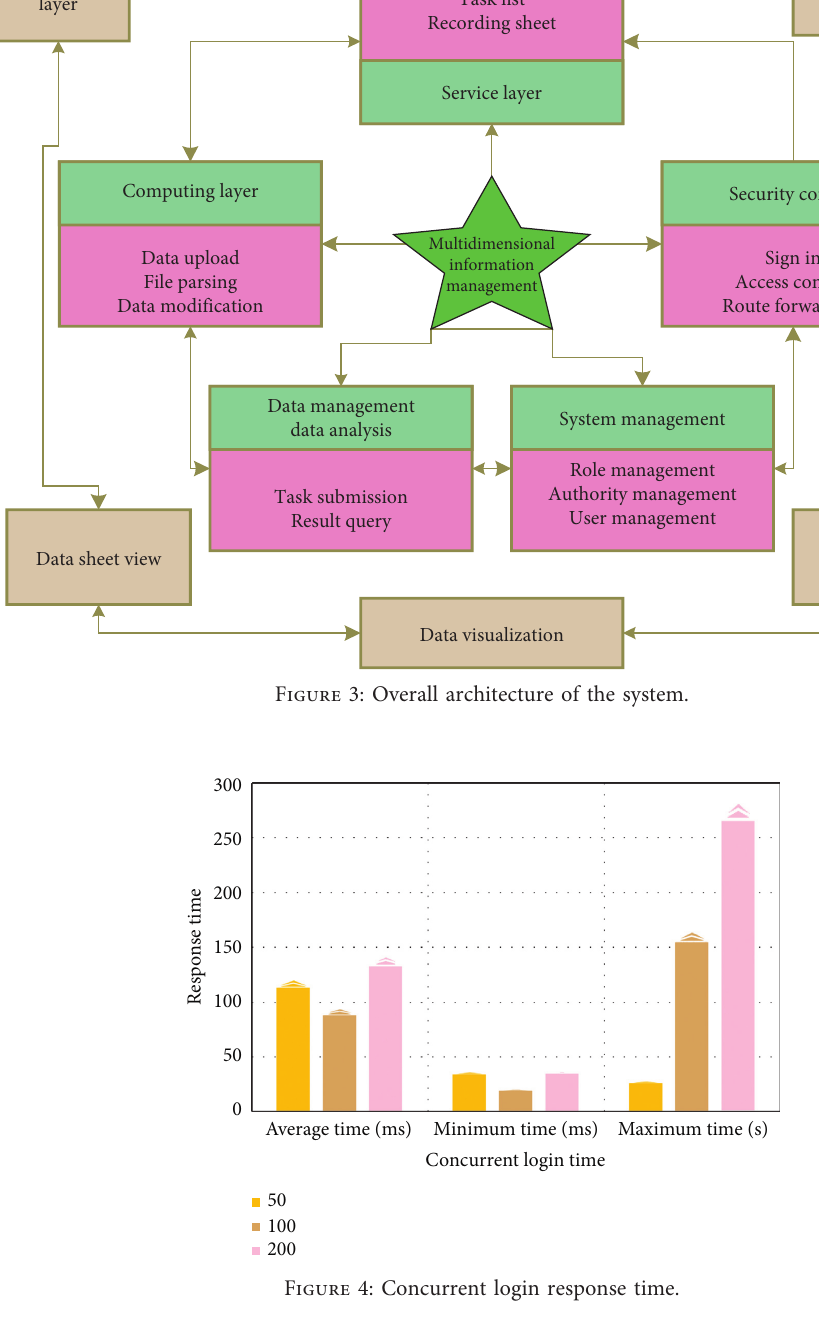
Figure 7. After submitting the classification task, the